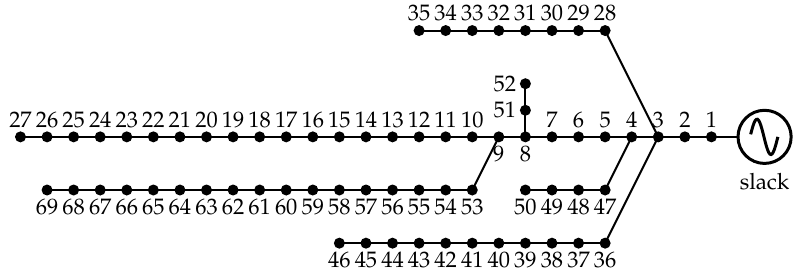
Figure 5. Schematic nodal connections in the IEEE 69-bus